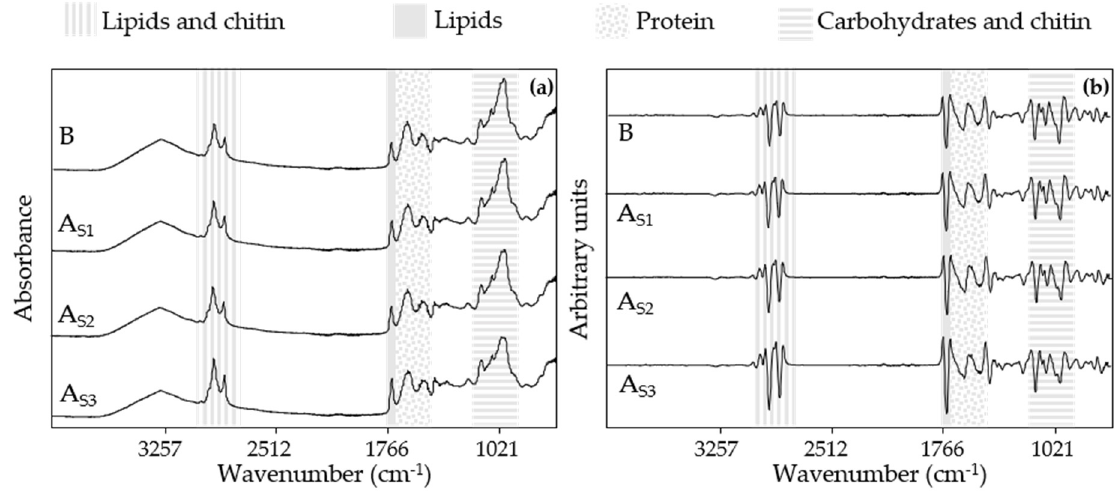
Figure 8. Raw mid-infrared spectra (4000 to 800 cm − 1 ) from the snacks made with A. diaperinus powder ( a ) and the transformed spectra (MSA and second derivative, 13 points) ( b ). Abbreviations used: Bs, blank snack with 0% insect powder; As 1 , snack with 7.2% of A. diaperinus powder; As 2 , snack with 14.4% of A. diaperinus powder; As 3 , snack with 21.9% of A. diaperinus powder.